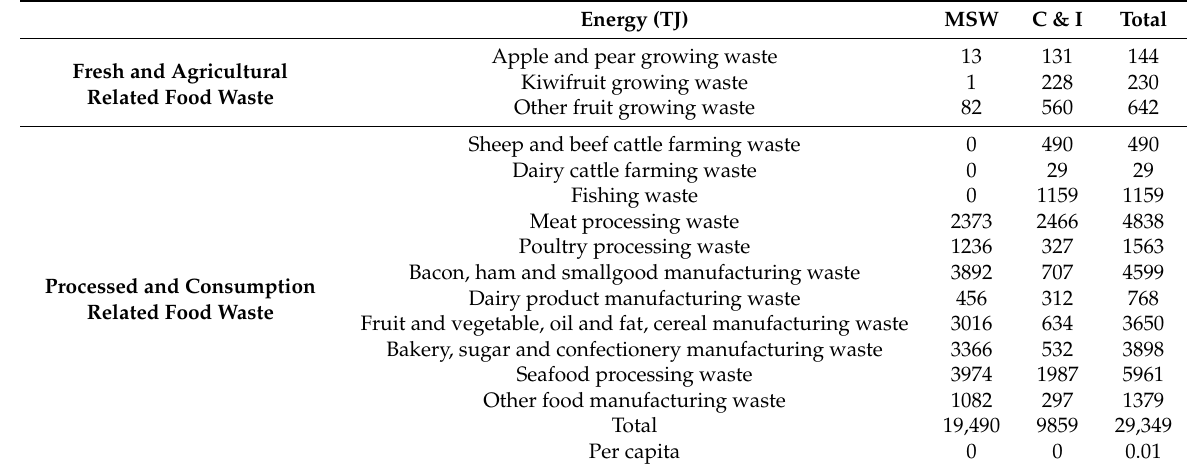
Table 5. Total Energy (TJ) embodied in food waste generated in New Zealand in